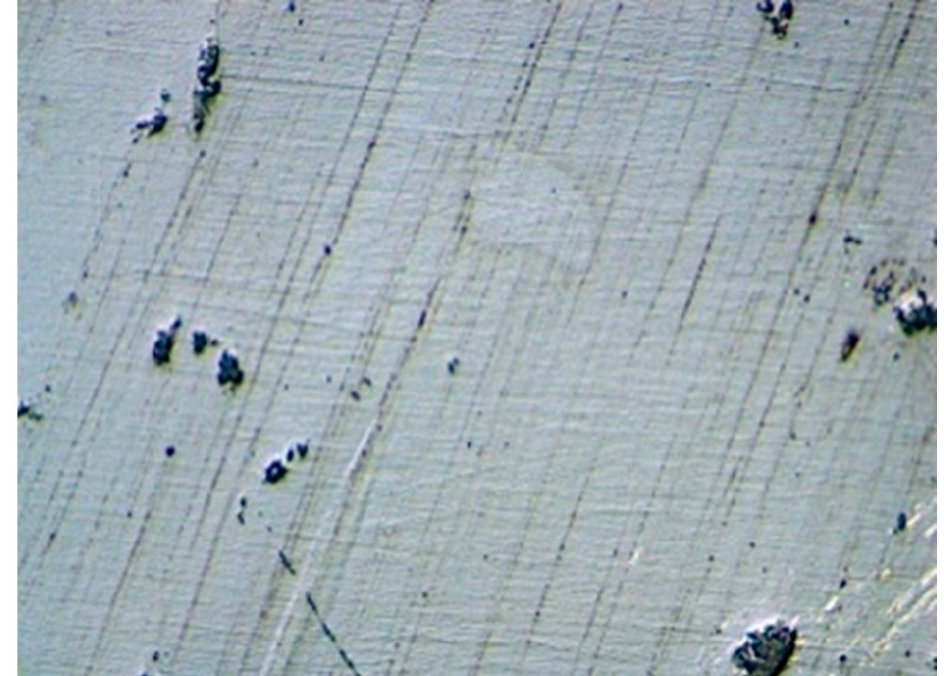
Figure 8. Roughness values R a (µm) after aging: median, interquartile range (IQR, 75th percentile